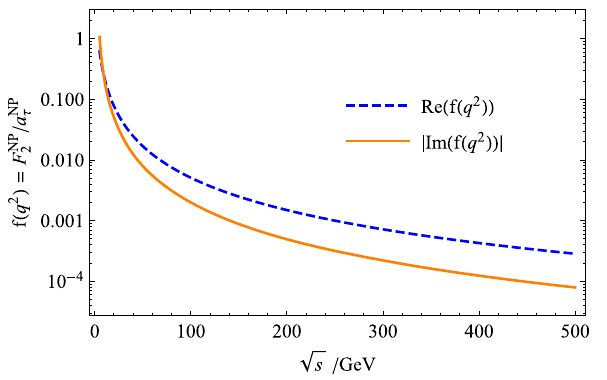
Fig. 1 The momentum dependence of the new physics contributions to the anomalous magnetic-moment form-factor according to the QED ansatz (9). Here, we denote s = q 2